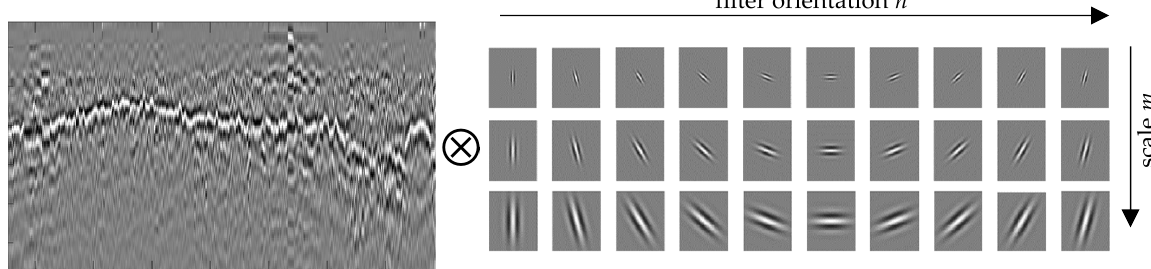
Figure 5. Left : typical radargram (B-scan) after standard signal pre-processing; right : some Gabor filters used for analysis (2D real part representation). These Gabor filter kernels can be changed in frequency (scale m ) and in orientation (angle n ) and then form a so-called filter bank.